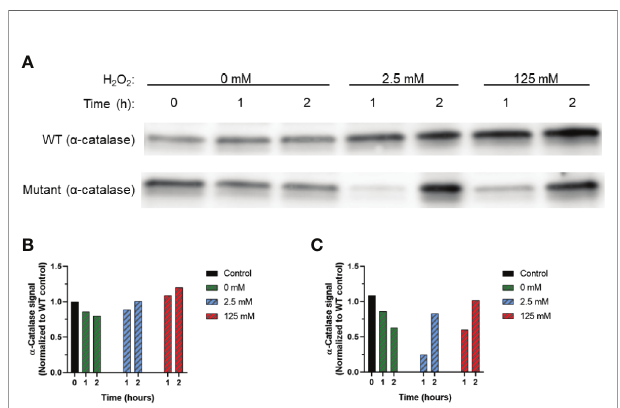
FIGURE 7 | Catalase (translational) response in WT S. Typhimurium and S. Typhimurium D csgA D wcaM D yihO D bcsE bio fi lms. Western blot was used to analyze total catalase content present in bio fi lms at each H 2 O 2 concentration from 0-2 hours. (A) Western blot demonstrating general catalase production from WT and EPS mutant bio fi lms. Densitometry analysis with ImageJ software (Schneider et al., 2012) was used to quantify Western blots of total protein collected from three independent bio fi lm challenge experiments for (B) WT or (C) EPS mutant bio fi lms. Densitometry values were normalized to the WT signal intensity at T 0 , 0